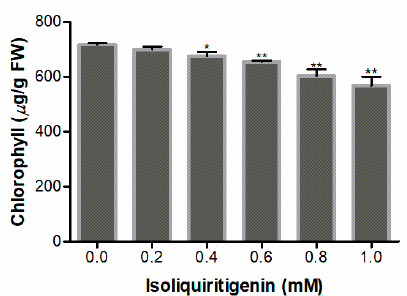
Figure 10. Chlorophyll content in lettuce seedlings after treatment with di ff erent concentrations of isoliquiritigenin. Data presented are the mean ± standard deviation of results from three independent experiments. N = 3. One asterisk * and two asterisks ** represent the significant di ff erence between the isoliquiritigenin-treated lettuce seedlings and the control at p < 0.05 and p < 0.01,